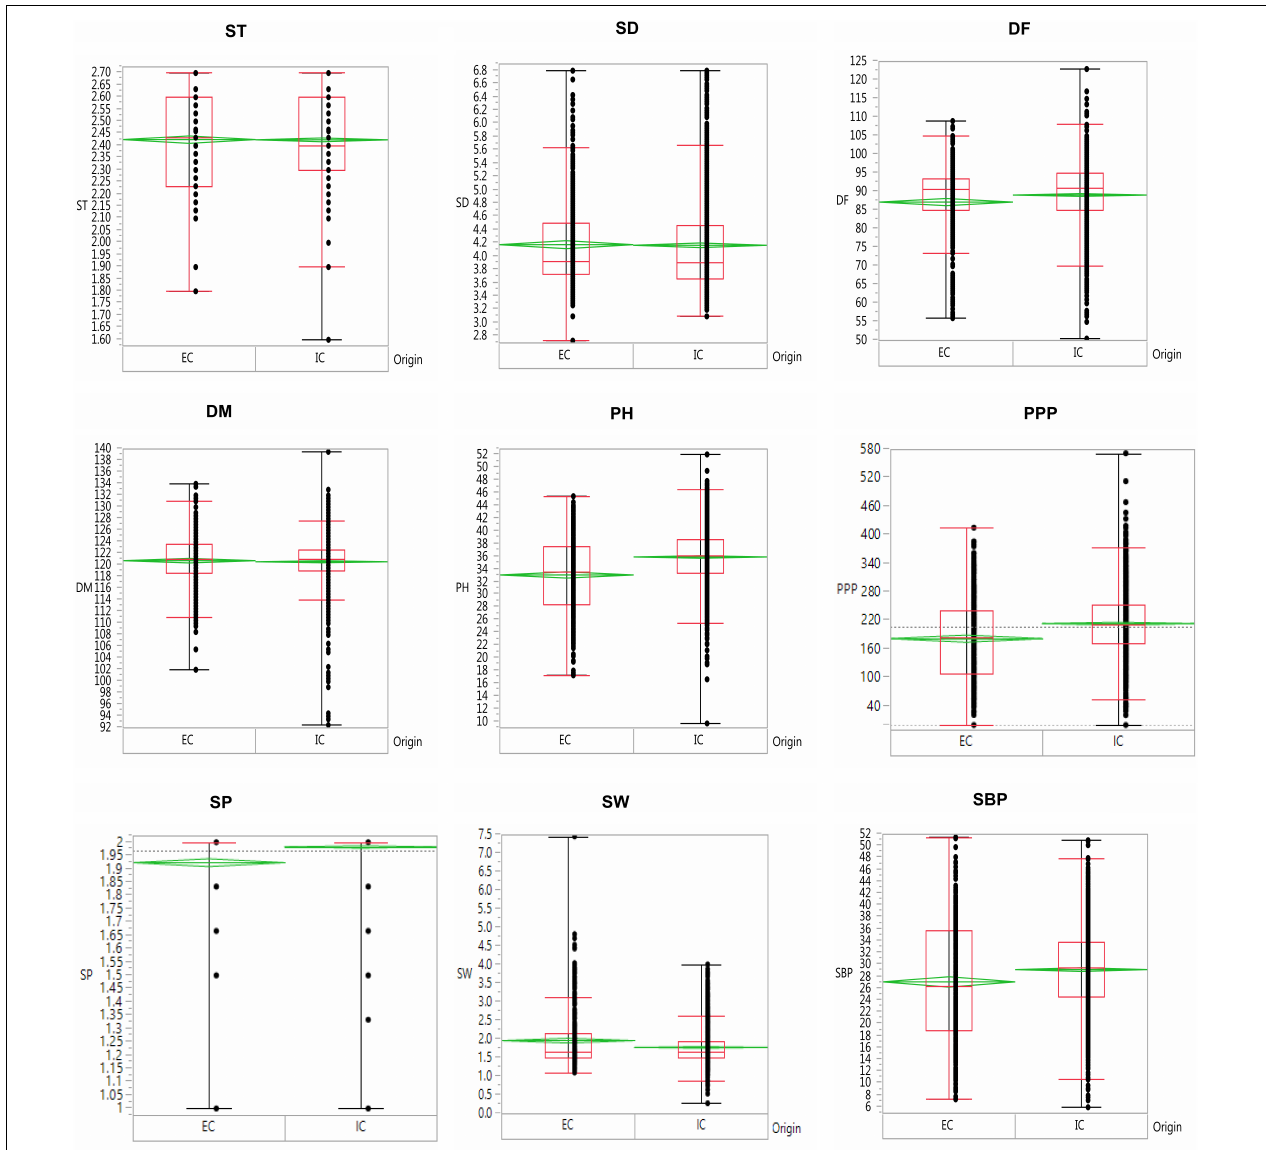
FIGURE 6 | Boxplot depicting the variability of traits in the indigenous collection (IC) and exotic collection (EC) of the entire lentil germplasm conserved in Indian national genebank.